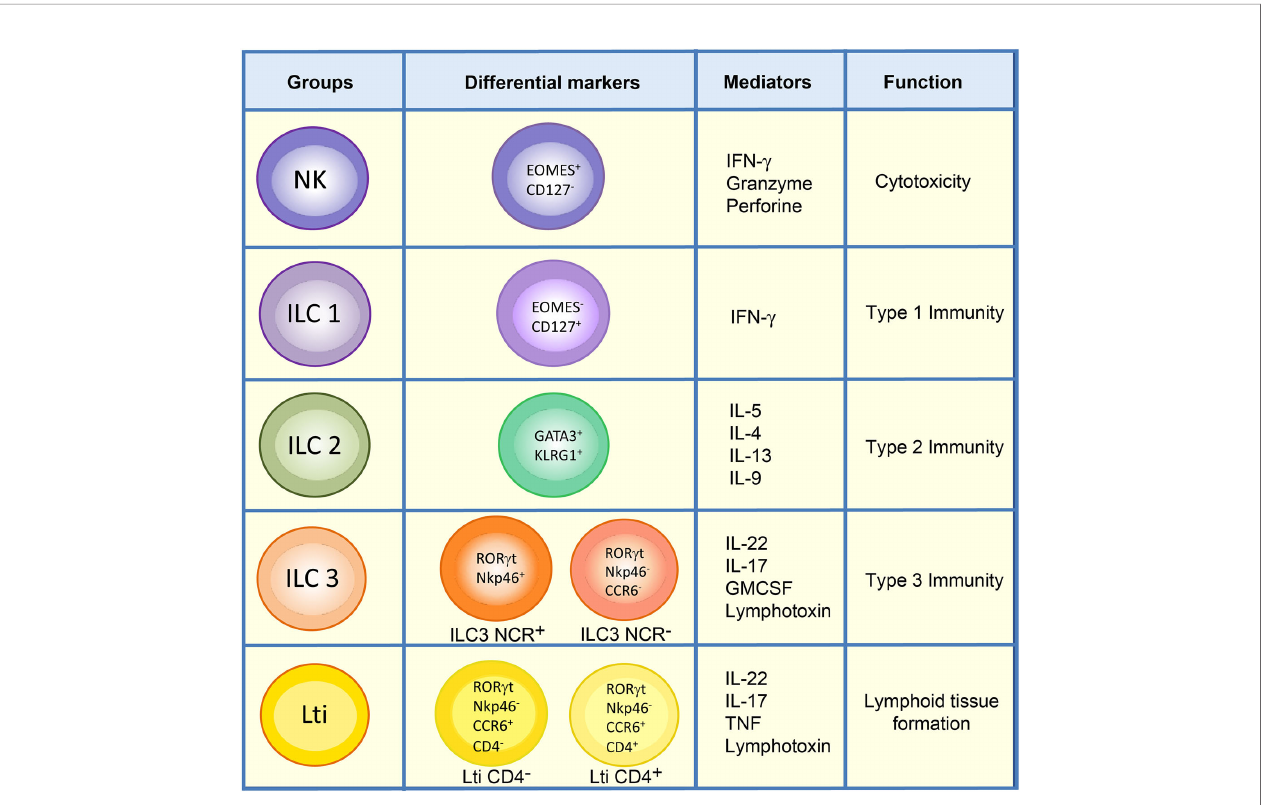
FIGURE 1 | Classi fi cation of ILCs. ILCs are classi fi ed into fi ve groups: NKs, ILC1s, ILC2s, ILC3s, and Lti cells. ILC1 and NK populations in the lamina propria of mouse intestine can be differentiated by the markers Eomes and CD127. Unlike ILC1s, NKs are mainly cytotoxic, and both types of cells direct type 1 immunity though the secretion of cytokines such as IFN- g . ILC2s express GATA3 and KLRG1 and are involved in type 2 immunity. The ILC3 group comprises ILC3 NCR + , which expresses Nkp46 in mouse, and ILC3 NCR - . They mediate type 3 immunity along with Lti cells, which can be distinguished from ILC3s by the expression of CCR6. Lti cells are highly relevant in the formation of lymphoid structures, and in adult mouse gut either CD4 + Lti or CD4 - Lti cells can be